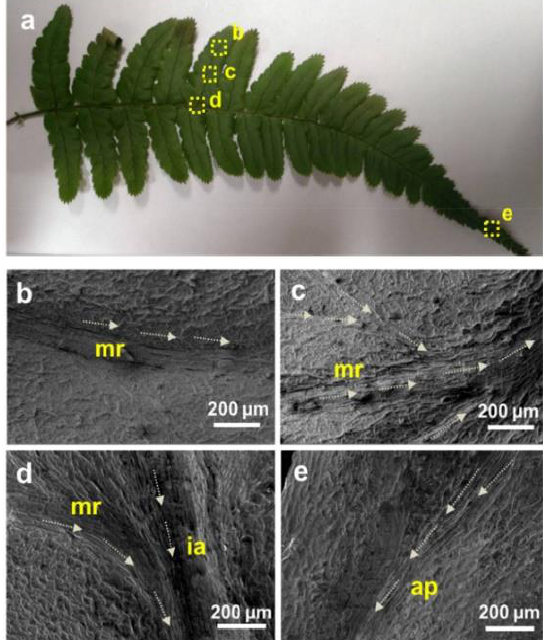
Figure 9. ( a ) Photograph of the D. marginata frond with labeled areas showing different locations of the water channels. ( b – e ) Scanning electron microscopy micrographs of the labeled areas in ( a ); arrows indicate the presumed direction of the water transport through these channels (ap: apex; ia: inner axis; mr: mid-rib)